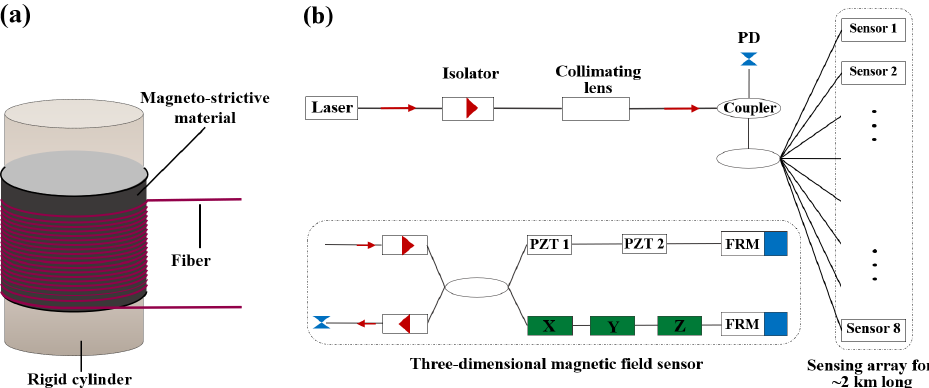
Figure 12. Magnetic field fiber sensors based on the cylinder type transducer with ( a ) a single-point [89] and ( b ) an array sensor [13].